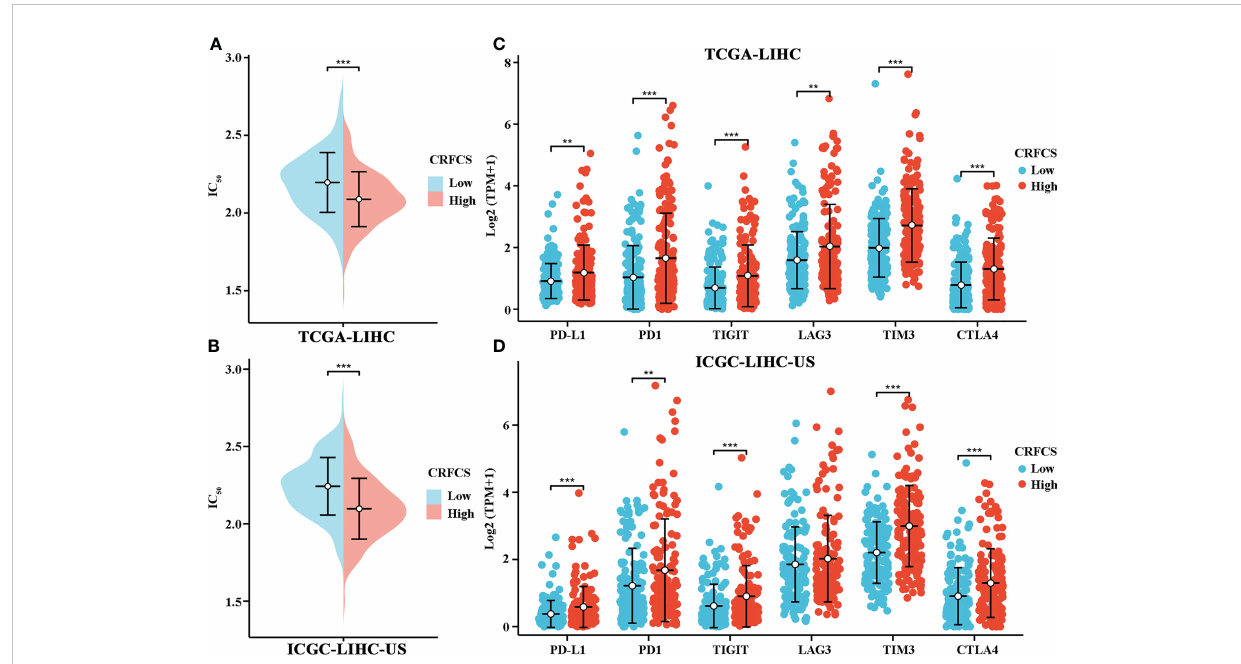
FIGURE 6 CRFCS and drug sensitivity. (A, B) Drug sensitivity of sorafenib in high and low CRFCS subgroups via analyzing data from TCGA cohort (A) and ICGC- LIHC (B) . (C, D) Differential expression of immune checkpoints between high and low CRFCS subgroups via analyzing data from TCGA cohort (C) and ICGC-LIHC (D) . (**p<0.01;